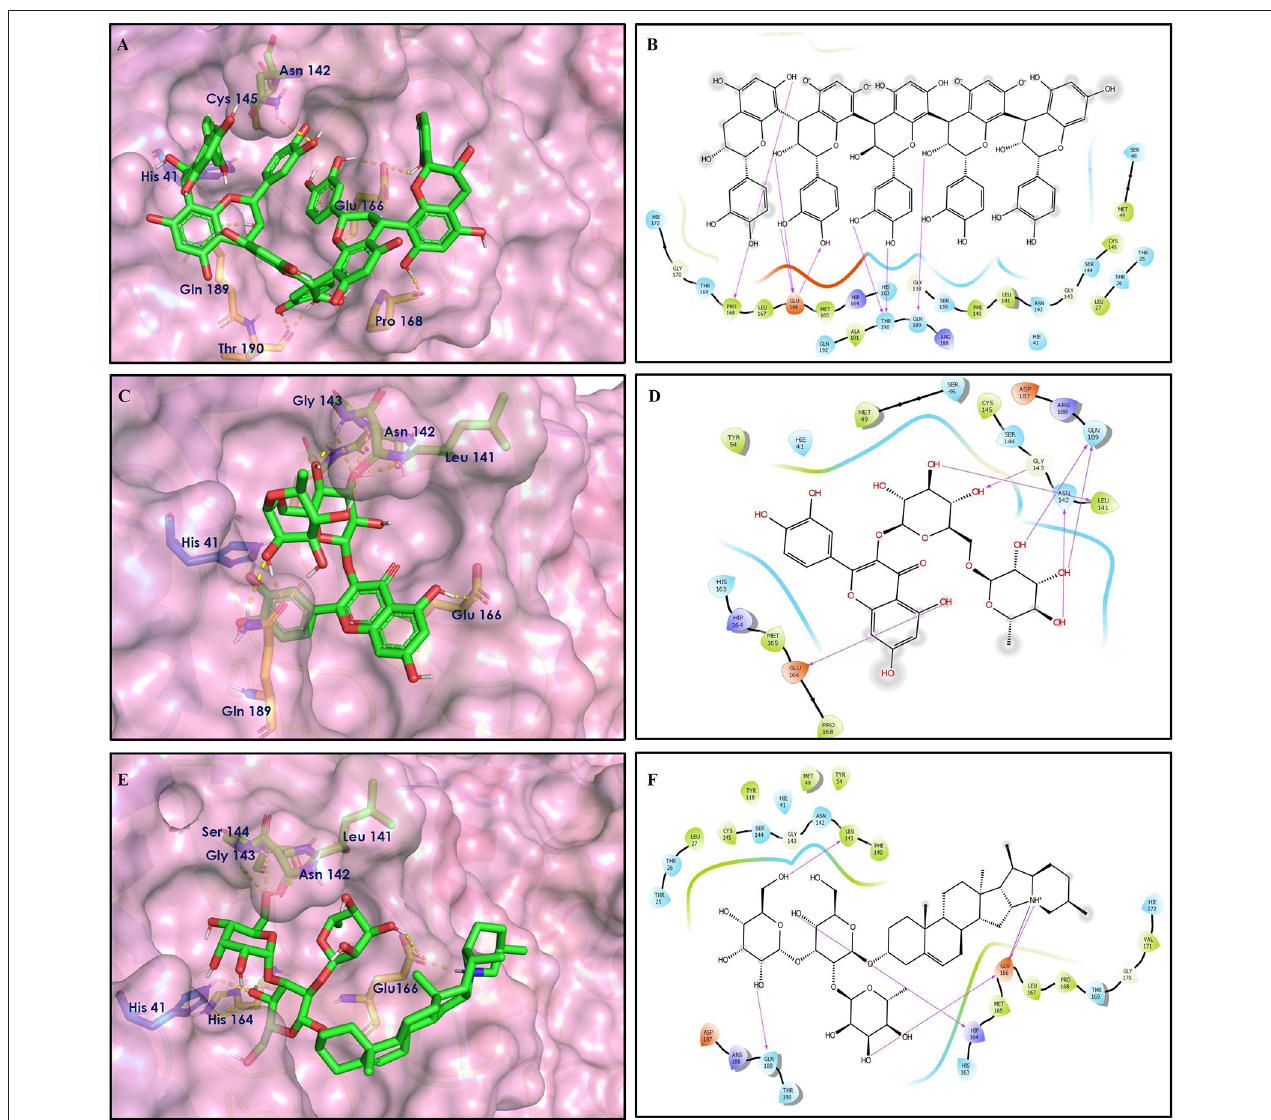
FIGURE 3 | Docking interactions of compounds (5, 6, 7 : A–F) in the active sites of Mpro. (A,C,E) 3D-binding mode of compounds 5 , 6 , and 7 with Mpro active site, respectively. Ligands are shown as green sticks, Mpro residues are shown as atom type color sticks, hydrogen bonds formed between ligands and receptor are depicted as yellow dotted lines, π - π stacking interaction is indicated as green dotted lines. (B,D,F) 2D-ligand interaction diagram of compounds 5 , 6 , and 7 with Mpro active site,